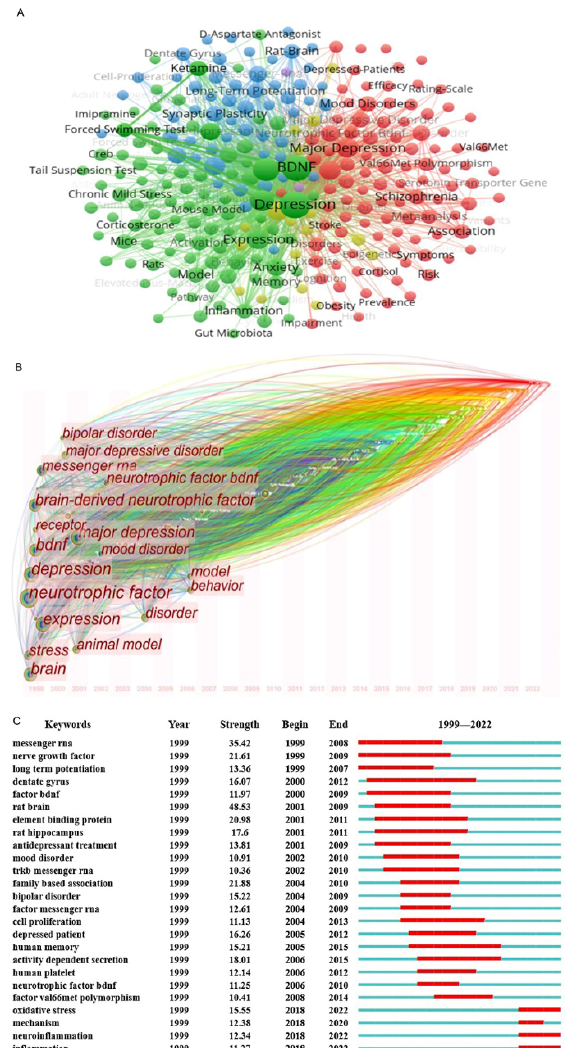
Figure 6. Keyword analysis. ( A ) Mapping of the timezone view on the association between de- pression and BDNF according to CiteSpace. ( B ) Mapping of the co-occurrence analysis among the keywords which occurred at least 40 times on the association between depression and BDNF ac- cording to VOSviewer. Node lines represent association strength. Node colors represent different clusters. ( C ) Top 25 keywords with the strongest citation bursts on the association between depression and BDNF.